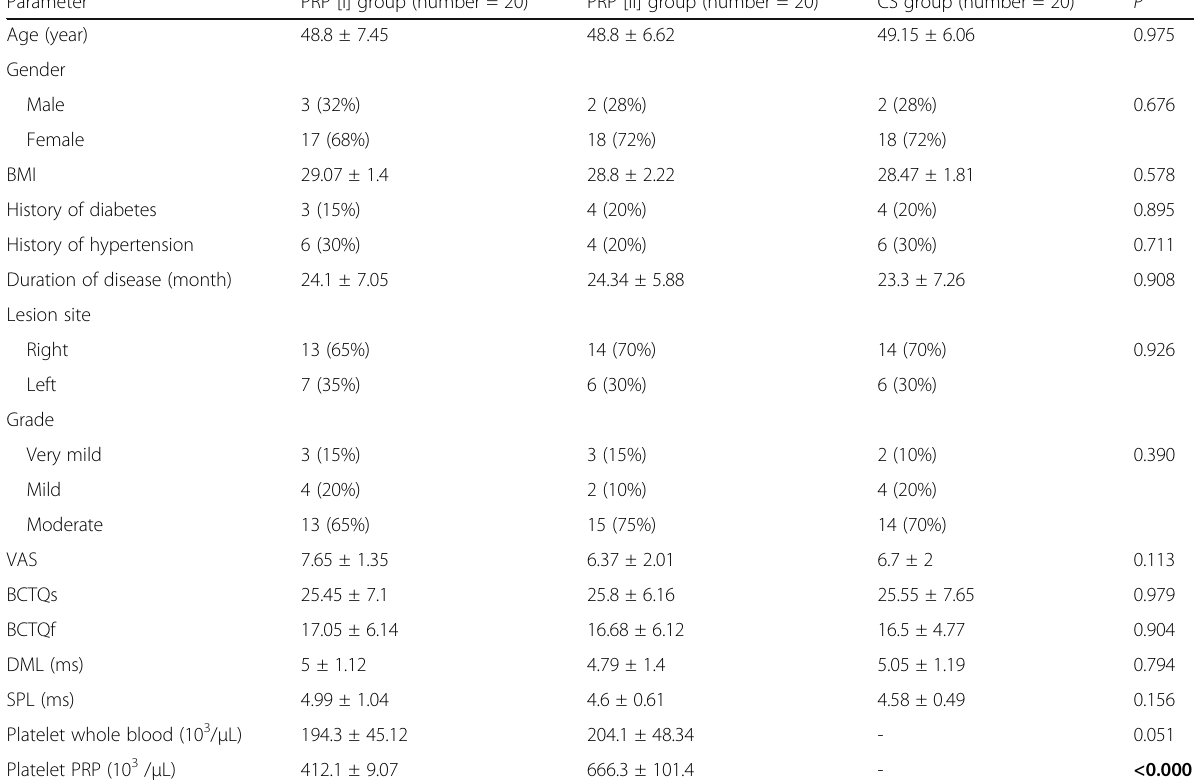
Table 1 Demographic and clinical characteristics of the study subjects